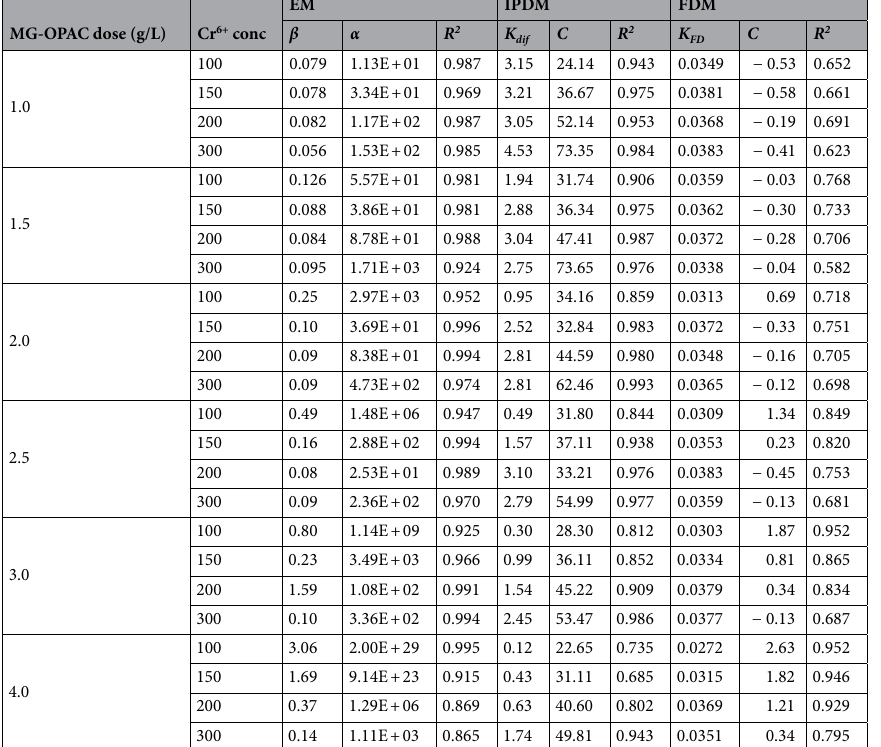
Table 4. The IPDM, EM, and FDM kinetic adsorption investigation